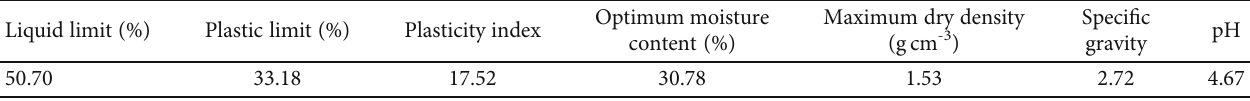
Table 1: Basic physical properties of red clay.